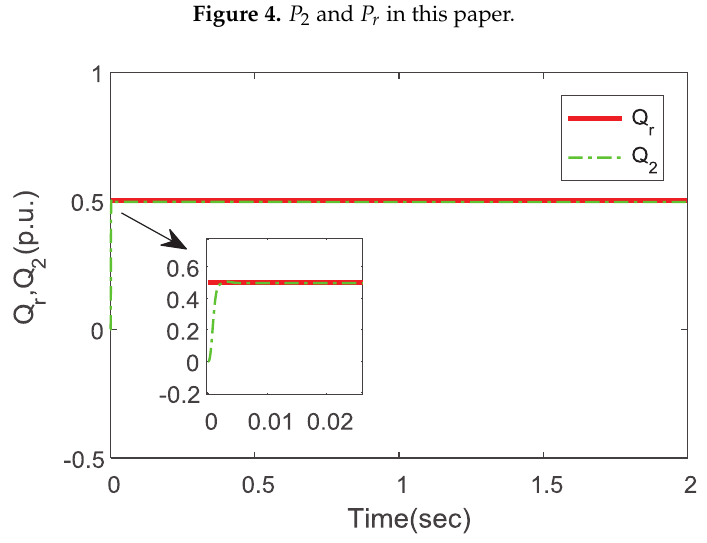
Figure 5. Q 2 and Q r in this paper.